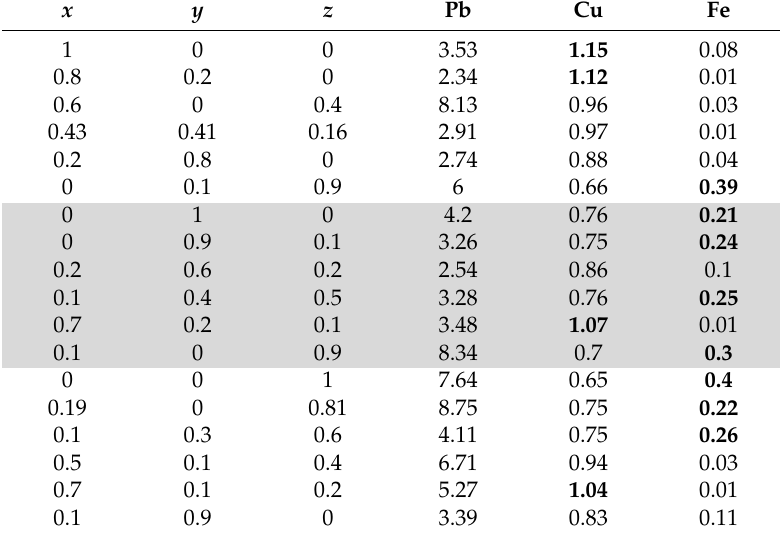
Table 3. Results of release models.